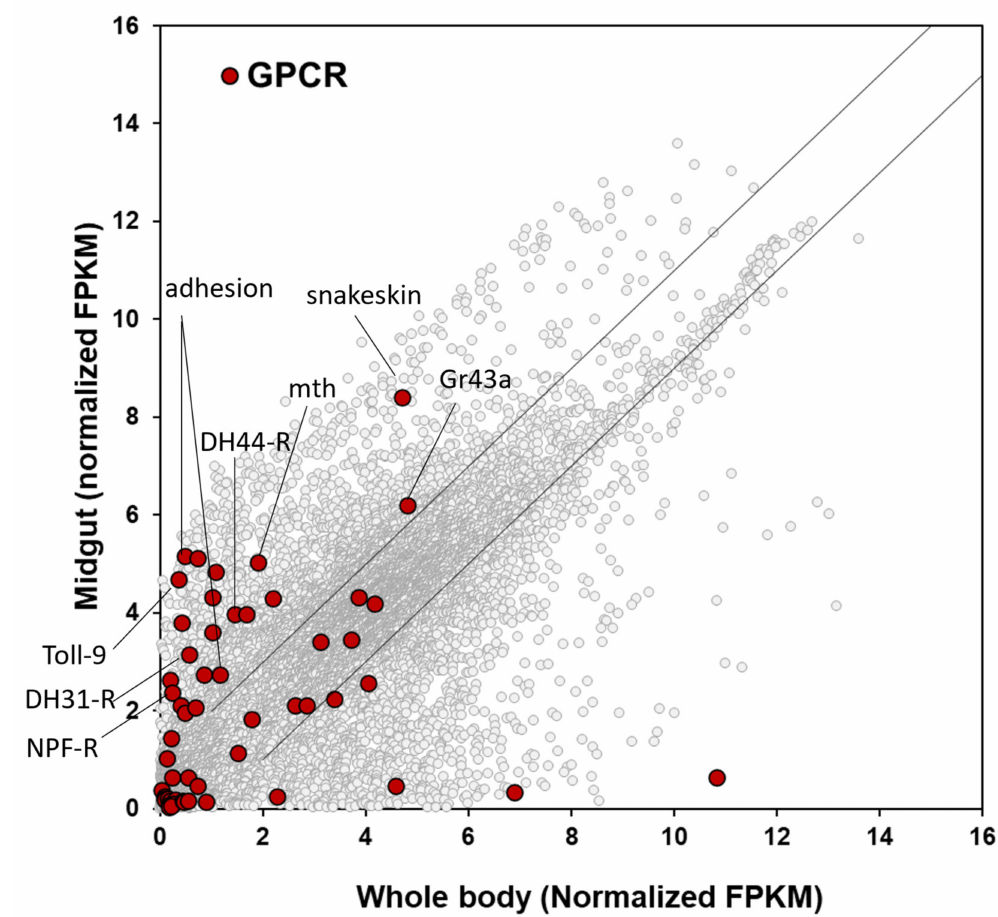
Figure 5. Scatter plot of the normalized gene expression levels of GPCRs between midgut and whole-body. Gene expression levels of different genes families are highlighted in different colors on the gray background scatter plot of total genes (8871) expressed in both midgut and whole-body. Two diagonal lines in the plot refer to |fold change (fc)| = 2. Snakeskin is a midgut membrane protein, not a